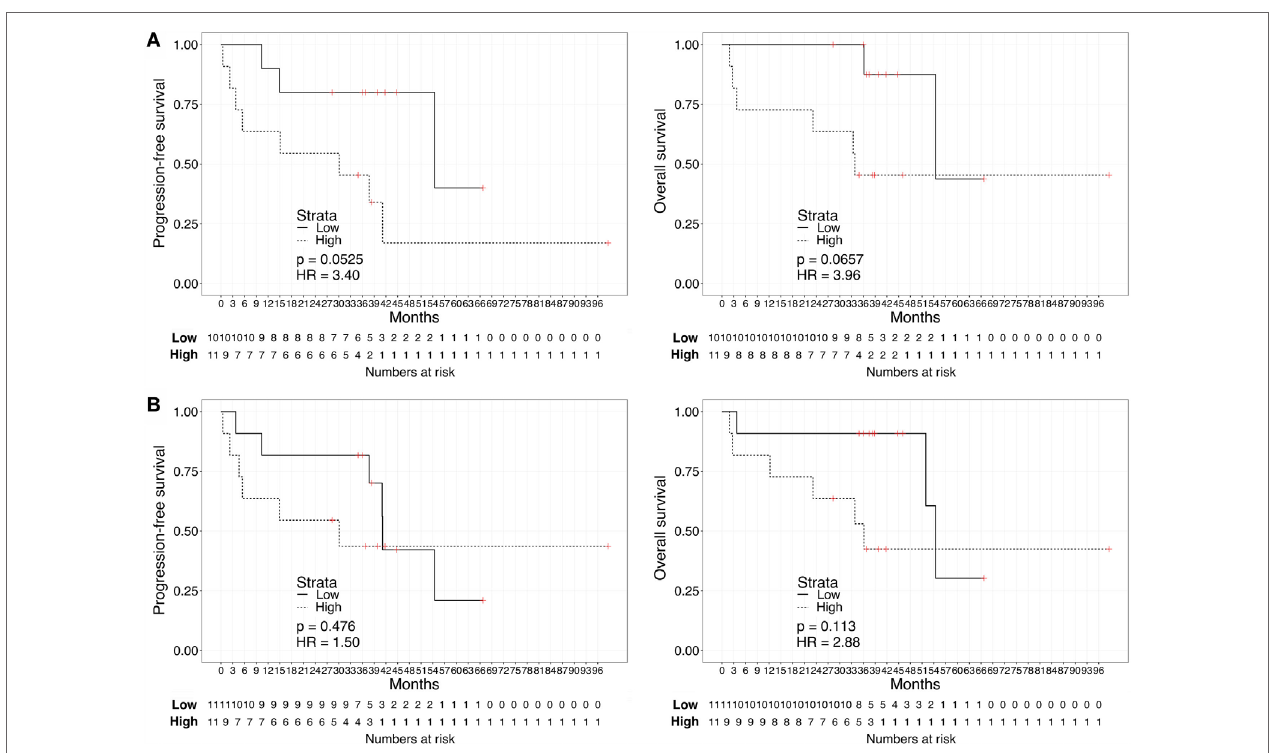
FigUre 4 | Kaplan–Meier curves for PFs (left) or Os (right) calculated from date of first treatment start for metastatic disease according to the urine (a) or plasma (B) biomarker score level . The prospective cohort of patients ( N = 23) was classified as “Low” (solid) vs. “High” (dashed) biomarker score at the time of